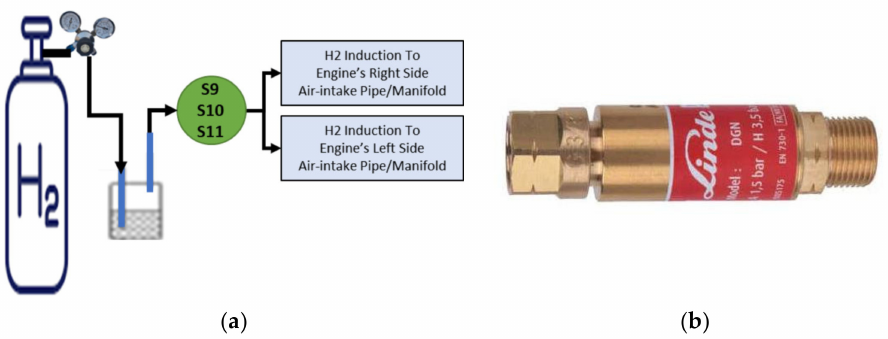
Figure 2. ( a ) Schematic of the H 2 supply unit configuration; ( b ) photo of the flashback arrestor that was installed in each side of the H 2 induction points.